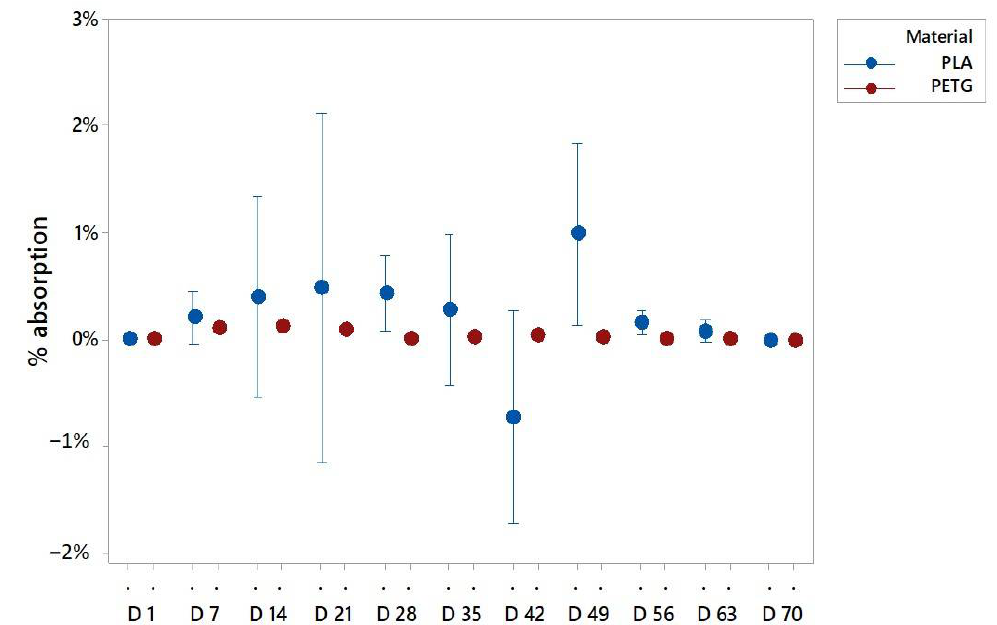
Figure 7. Water absorptions of PLA and PETG specimens in a fully saturated solution with distilled water and salt, where D is the day of the evaluation of absorption .